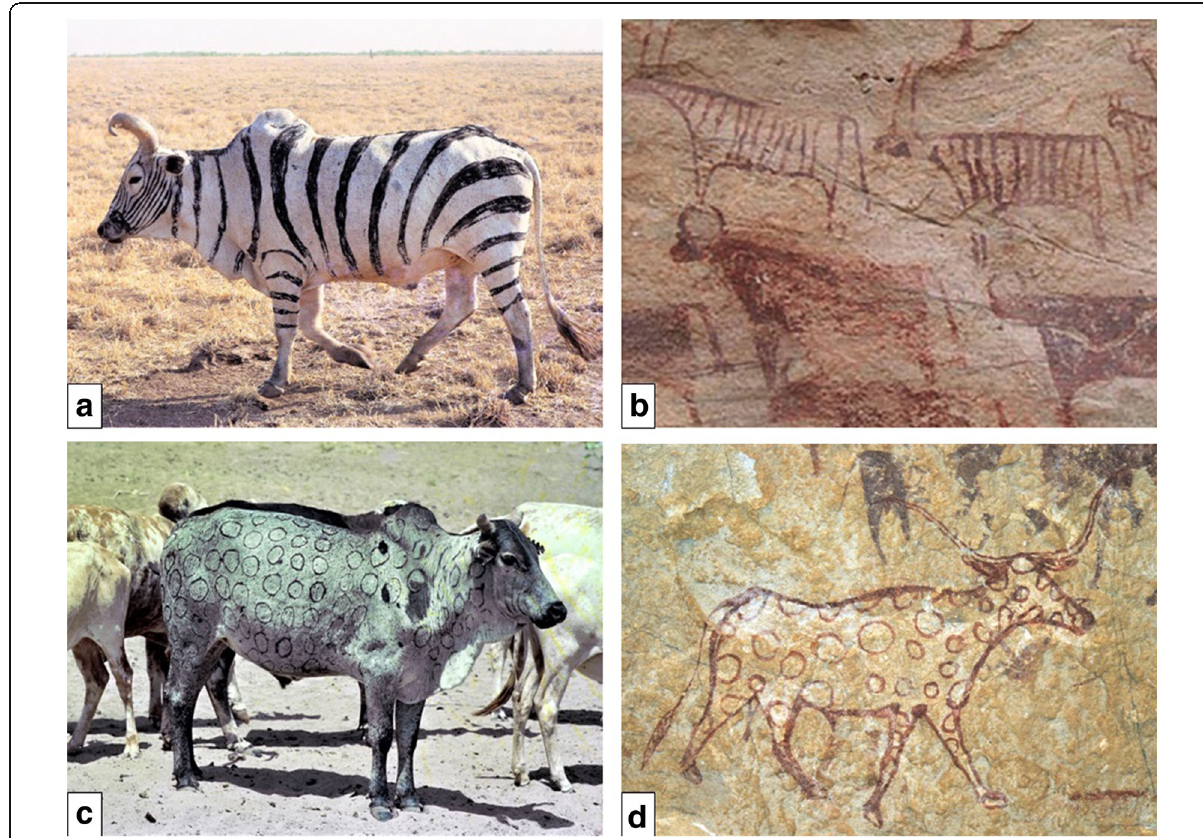
Fig. 4 Modern day favourite-oxen on the left and their mirror-like representation in prehistoric rockart of various African areas on the right. a “ Striped ox ” , Lotikipi Plain. b Ox with a similar coat modification from rock art found at Sullum Ba ’ atti, Eritrea (courtesy G. Calegari). c “ Circled ox ” , Lotikipi Plain. d Ox with a similar coat modification from rock art found in Immidir, Algeria, approx 4000 BC (courtesy Y.